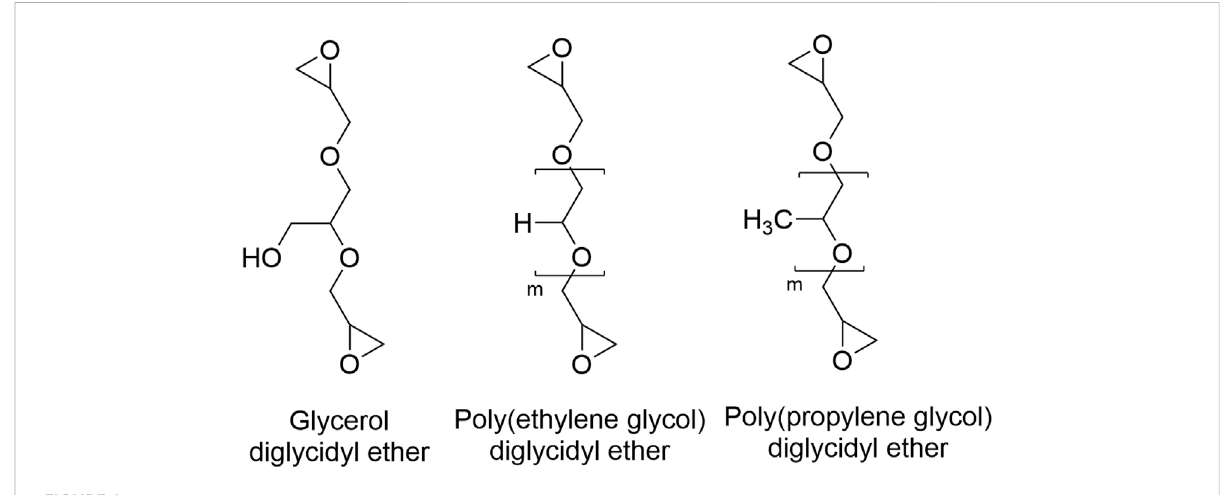
FIGURE 1 Chemical structure of the three diglycidyl ethers investigated as